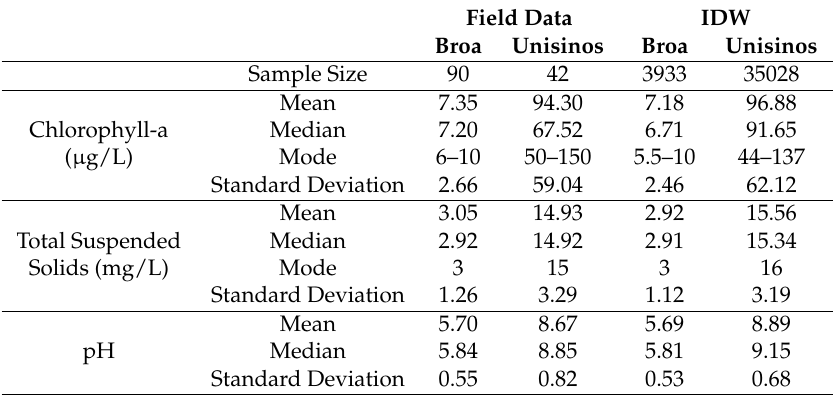
Table 1. Descriptive statistics of the field data and post IDW interpolation.